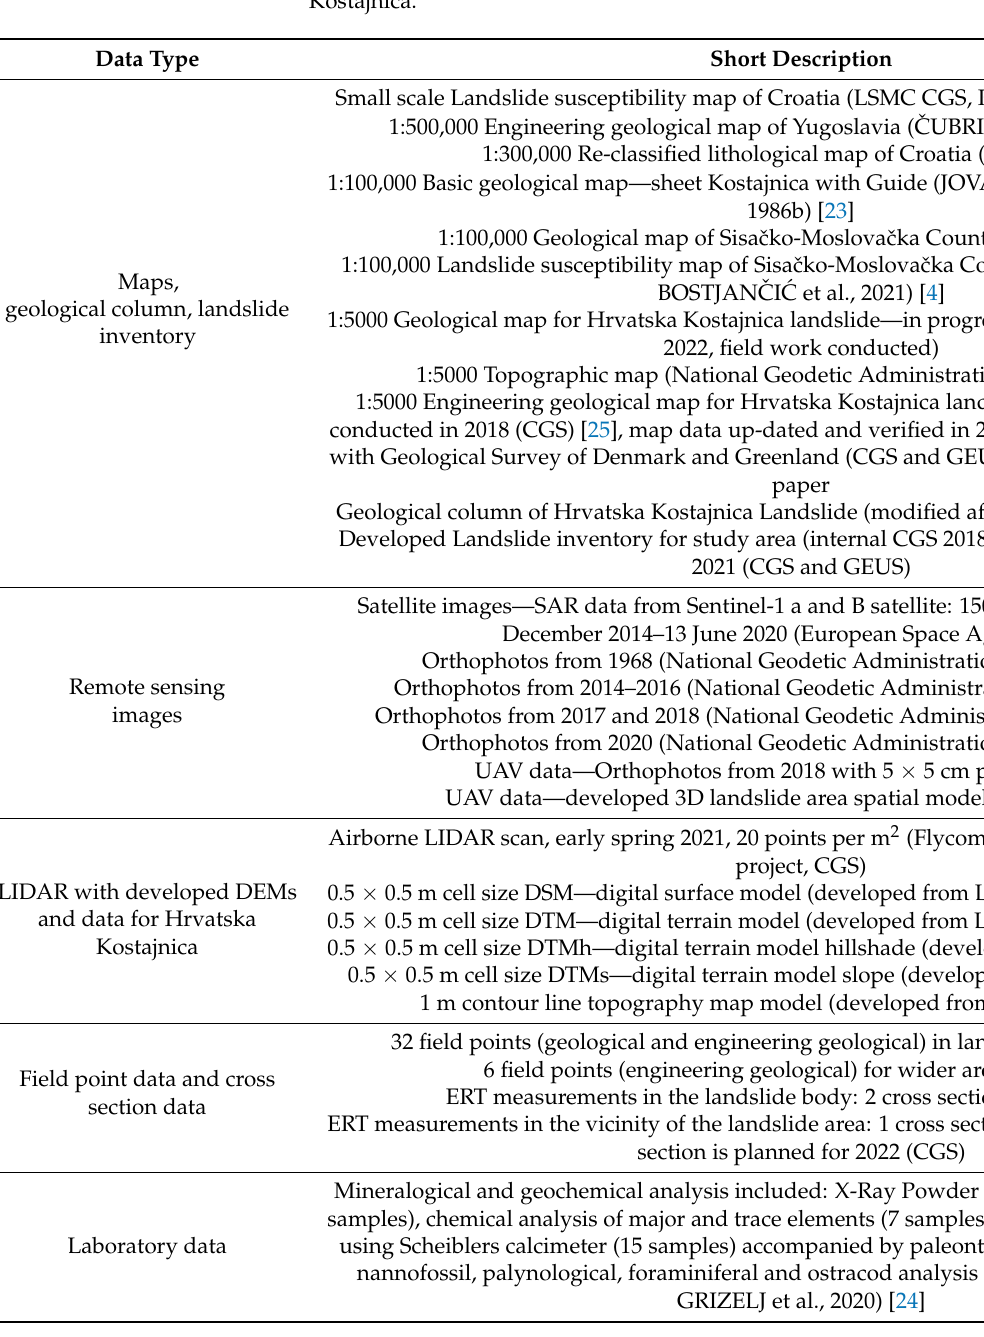
Table 1. List of reviewed and analysed main data sets for the study area i.e., landslide in Hrvatska